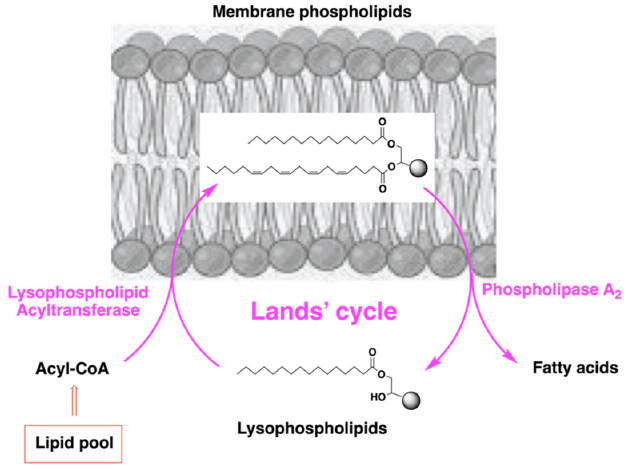
Figure 4. The remodeling mechanism for membrane phospholipid turnover.